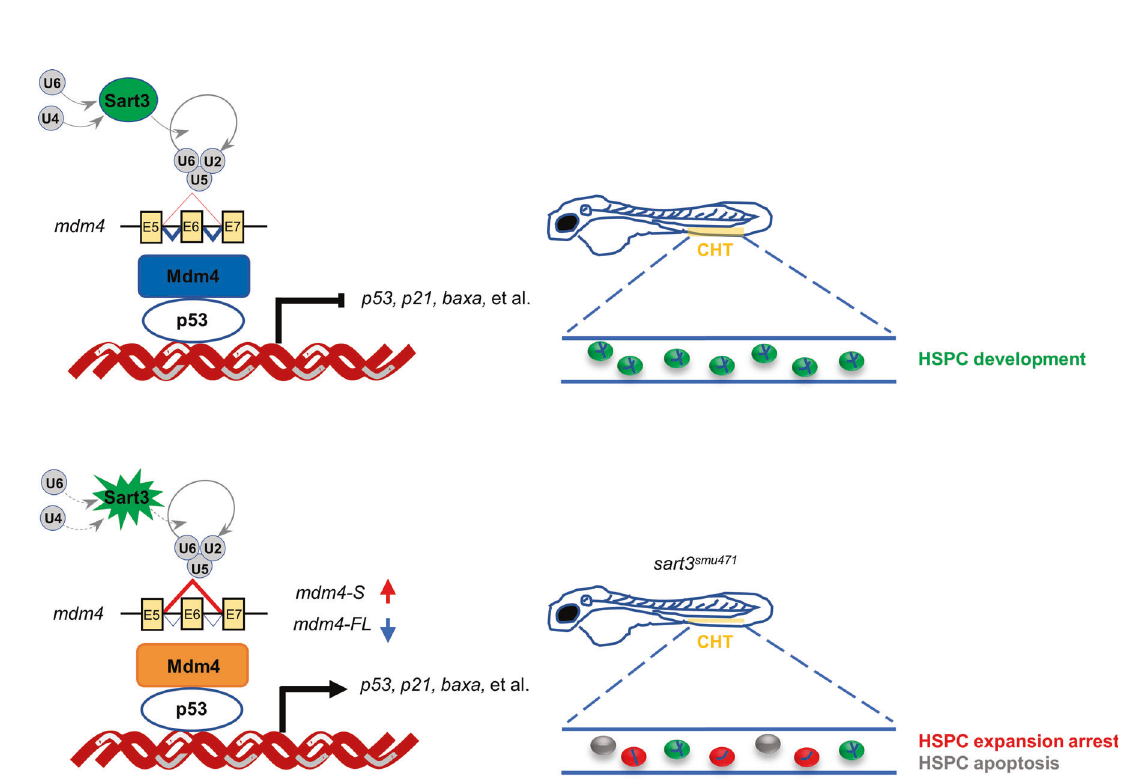
Fig. 6 Schematic diagram of Sart3-Mdm4-p53-regulated HSPC development in zebra fi sh. Schematic diagram of HSPC development regulated by Sart3-Mdm4-p53 pathway in zebra fi sh. Sart3, which could recycle U4 and U6 snRNPs into spliceosome assembly to affect pre- mRNA splicing [43], promotes HSPC development (current study). Mutation of Sart3 (highlighted in burst) reduces ef fi cient recycling of U4 and U6 snRNPs (broken lines) so that normal splicing of mdm4 is disrupted. Mdm4 exon 6 (E6) skipping by sart3 mutation results in increased truncated mdm4 transcript ( mdm4-S ) and decreased mdm4 full-length transcript ( mdm4-FL ). The insuf fi ciency of Mdm4 (orange rectangle) triggers activation of p53 pathway and promotes HSPCs to undergo proliferation arrest and apoptosis in zebra fi sh early hematopoiesis.